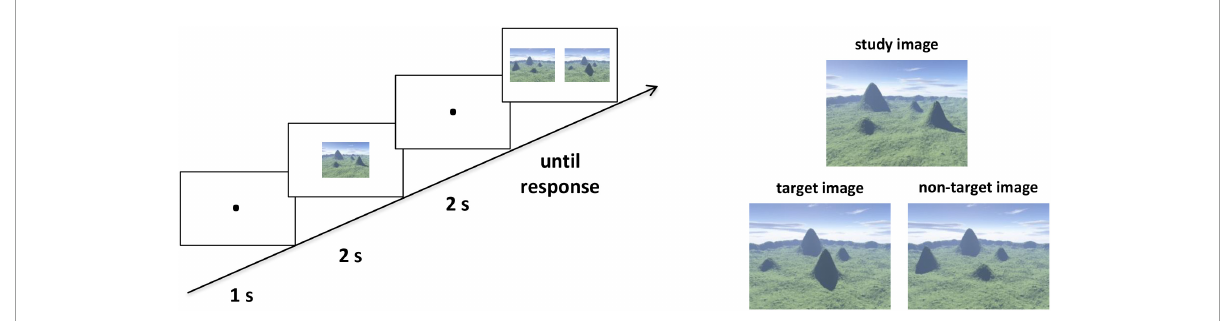
FIGURE1 The ordinal scene recognition task to assess categorical spatial relations. Left panel: Example of a single trial. The participants were asked to identify the target image as quickly and accurately as possible in the test phase. Right panel: Examples of the study and test images. Two images were presented in the test phase, one of which was the target image and the other was the non-target image. The target image preserved all ordinal information from the study image but with a novel viewpoint. For the non-target image, the locations of two mountains were exchanged to the study